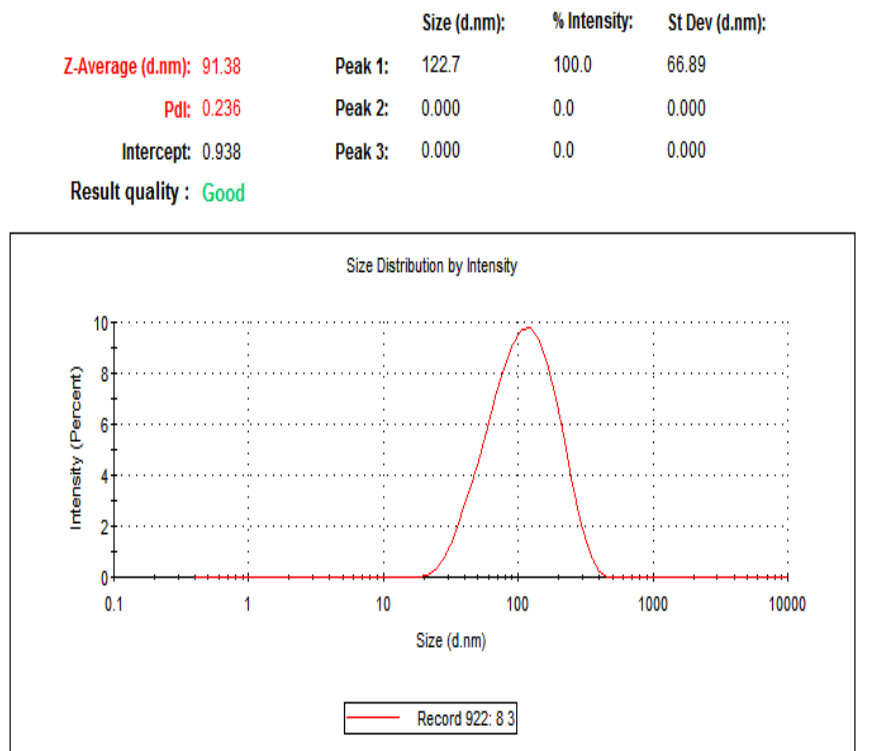
Figure 1. A Zetasizer was used to determine the average size of the AgNPs biosynthesized with L. chinensis extract.